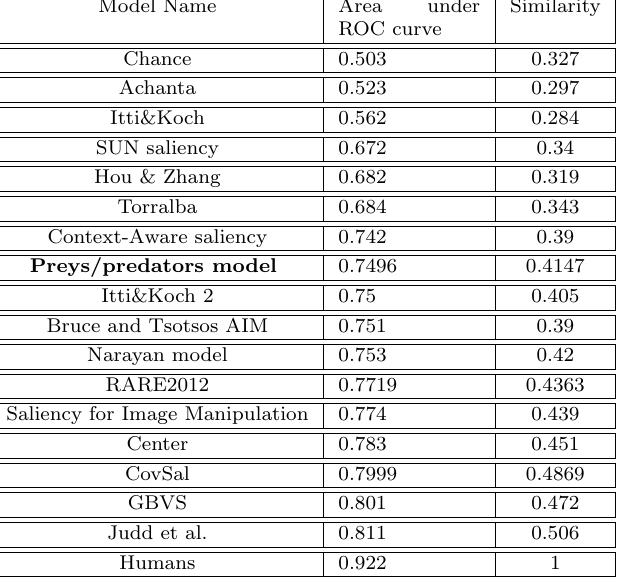
Table 1. A comparison of several models realised by T.Judd.